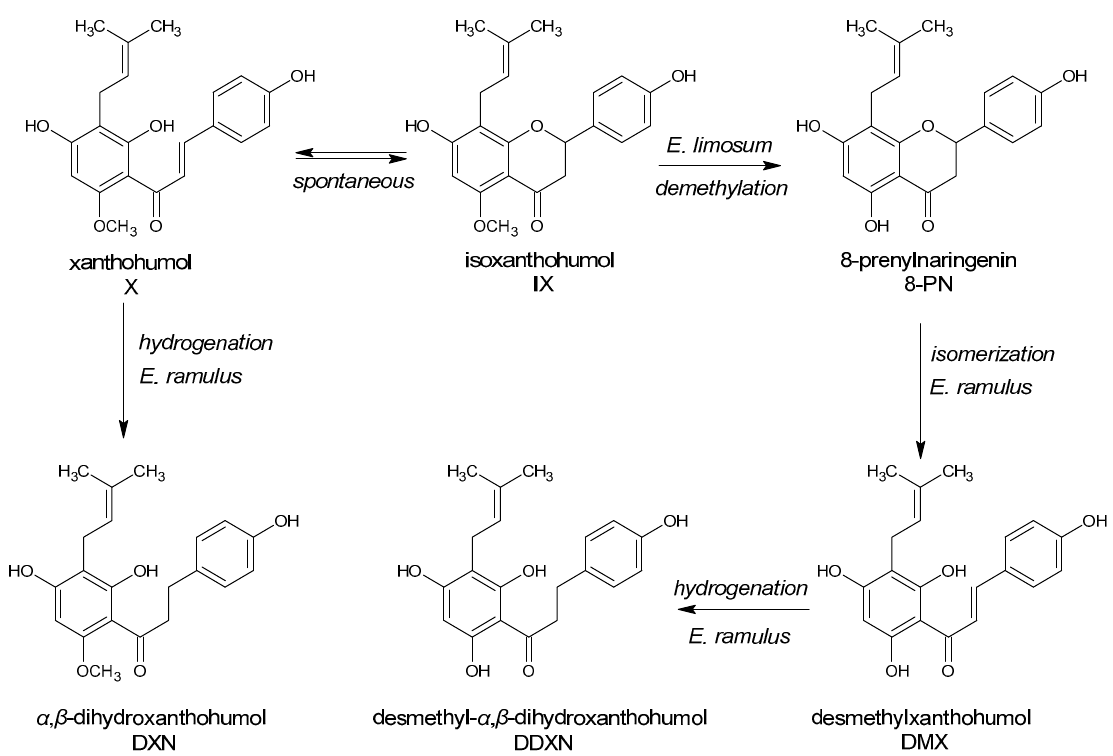
Figure 11. Bacterial biotransformation of prenylflavonoids xanthohumol and isoxanthohumol. Based on [275,276,279].